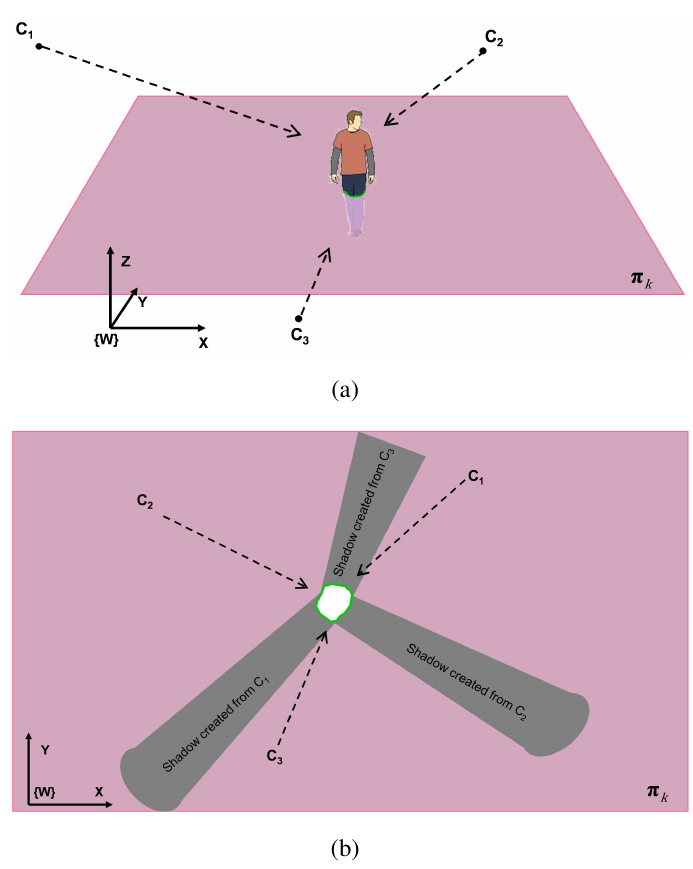
Figure 11. Illustration of the 3D registration framework using homography concept. ( a ) A scene including a human and three cameras is depicted. π is one inertial-based virtual world k plane. The cameras c , c , and c are observing the scene. ( b ) The registration layer (top 1 2 3 view of the plane π of (a)). Each camera can be interpreted as a light source and our GA k (Algorithm 5) based optimal configuration was used to obtain the final placements and 3D reconstruction experimental